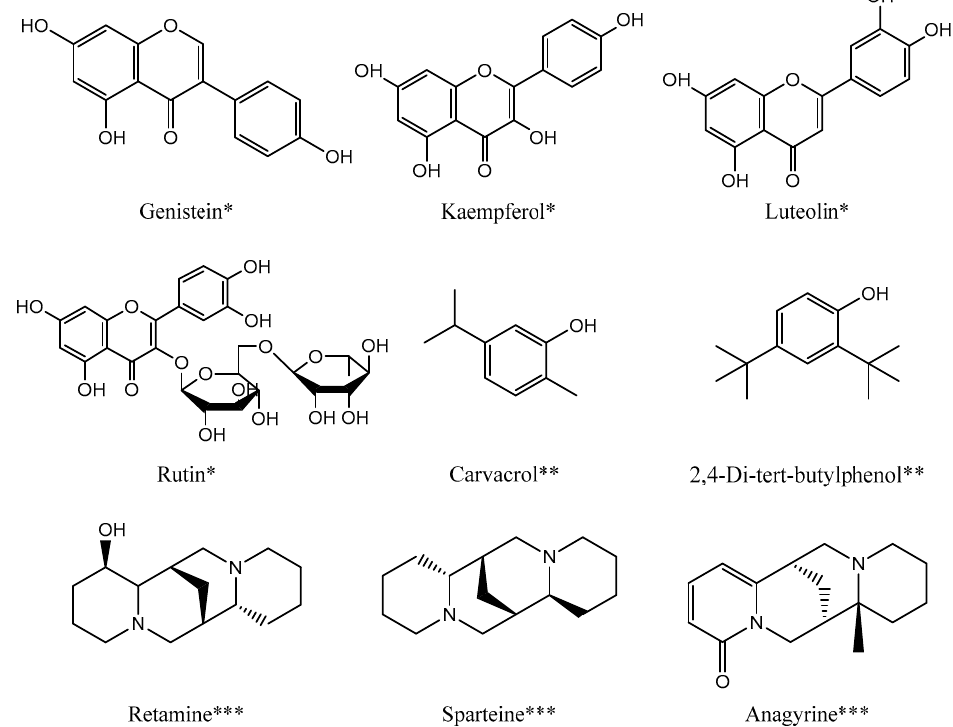
Figure 1. Some chemical structures of flavonoids (*), phenols (**), and alkaloids (***) were isolated from Retama monosperma .